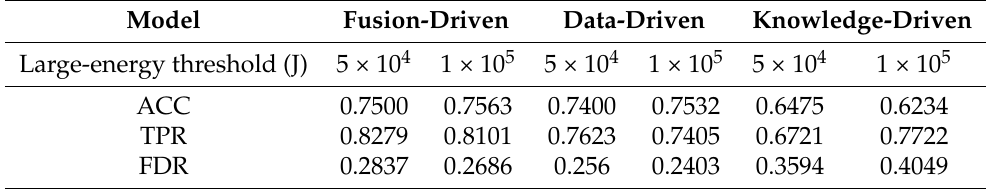
Table 5. Test results of single-driven model and fusion-driven model. Model Fusion-Driven Data-Driven